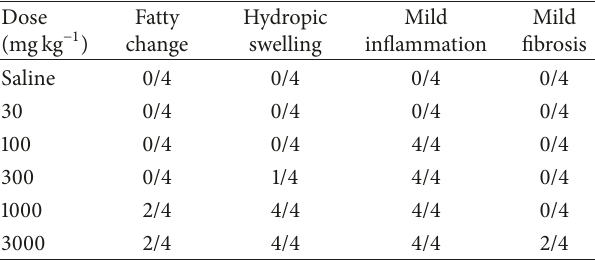
Table 5: Histopathological results of the liver in rats orally treated with PME for 2